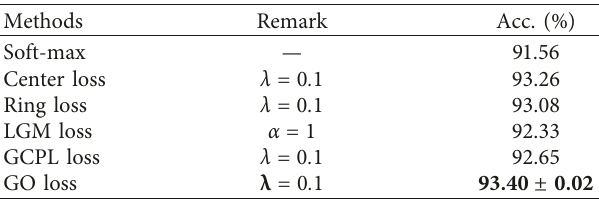
0 and (b) λ 1 on MNIST. Different colors represent different class. (cid:29) (cid:29) Table 3: Classification accuracy with SampleNet on Fashion- MNIST dataset.